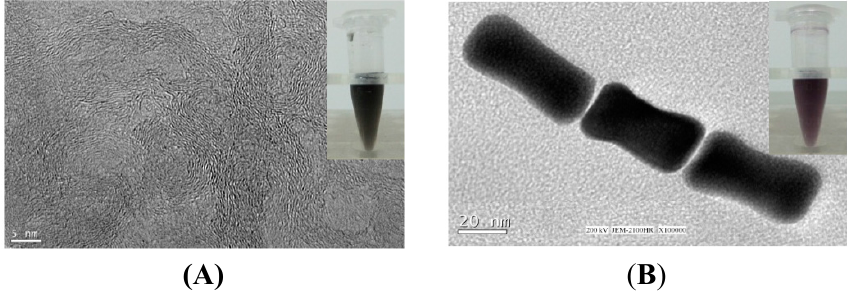
Figure 2. TEM images of ( A ) SWCNTs and ( B )